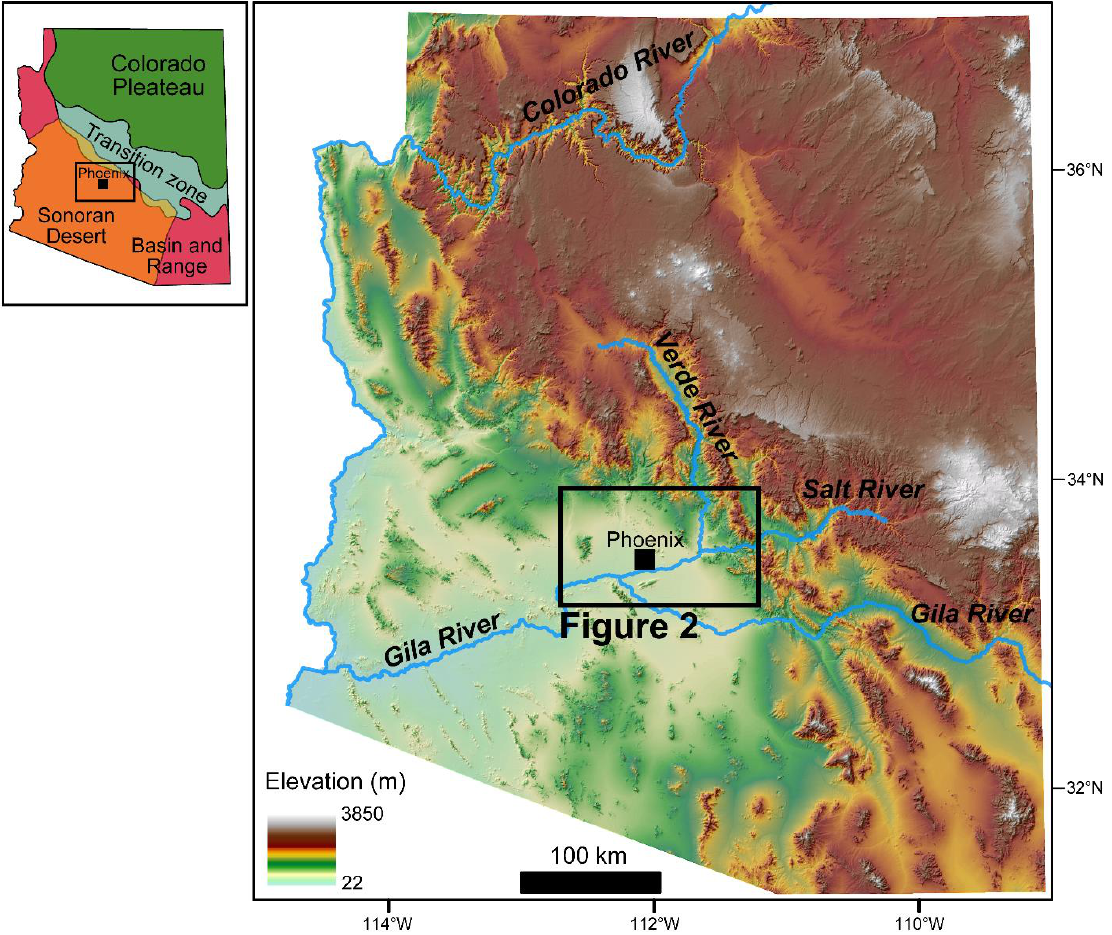
Figure 1. Topography of Arizona, United States with the studied watersheds found within the box. This study area occurs in the climatological Sonoran Desert and within a geological Basin and Range Province where the Salt, Verde, and Gila rivers flow through the Phoenix metropolitan region, Arizona, United States.